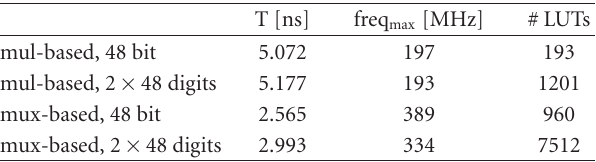
Table 1: Shift register post-place & poute